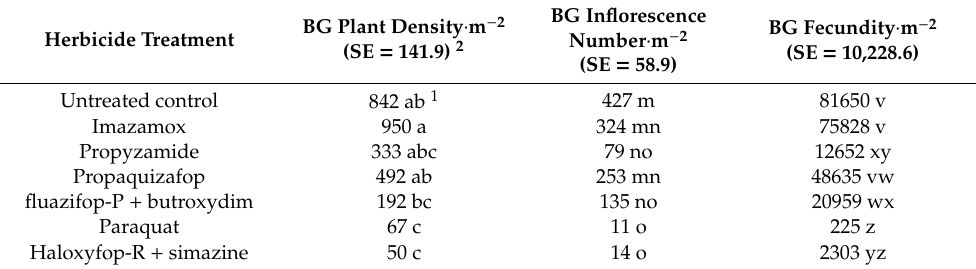
Table 7. Mean responses to herbicide treatments on barley grass plant density, inflorescence number, and fecundity during August 2017 within a barley grass-infested mixed pasture at Charles Sturt University in Wagga Wagga,